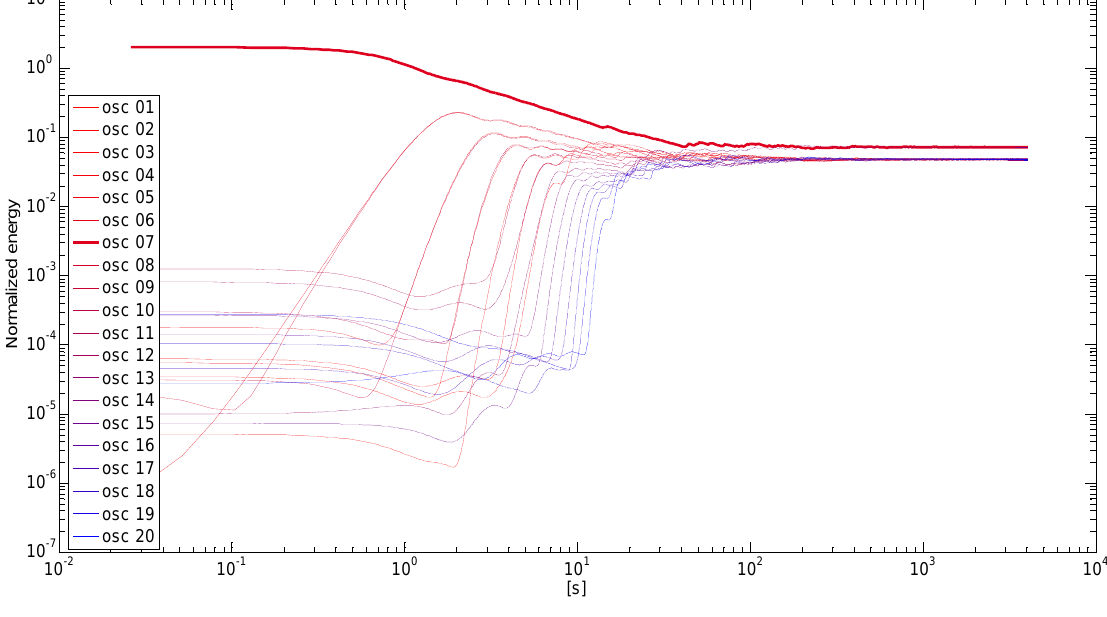
Fig. 9. Uniform chain, time energy averages versus time, x, y axes in log scale.